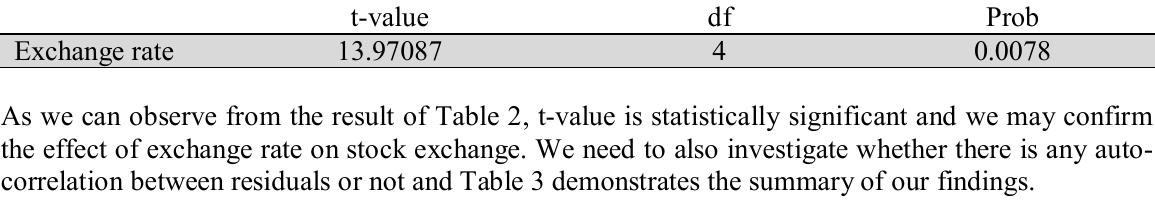
The summary of the effects of exchange rate on stock exchange